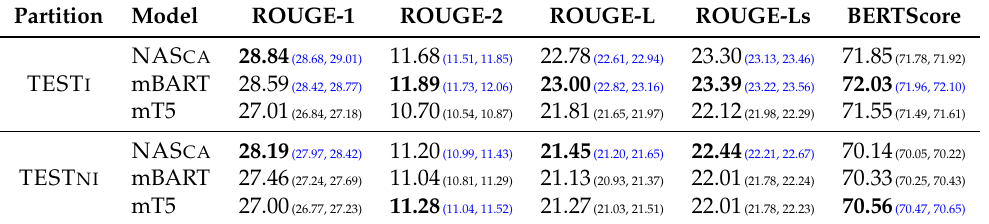
Table 5. Average F1 scores and confidence intervals of models in summarization task in